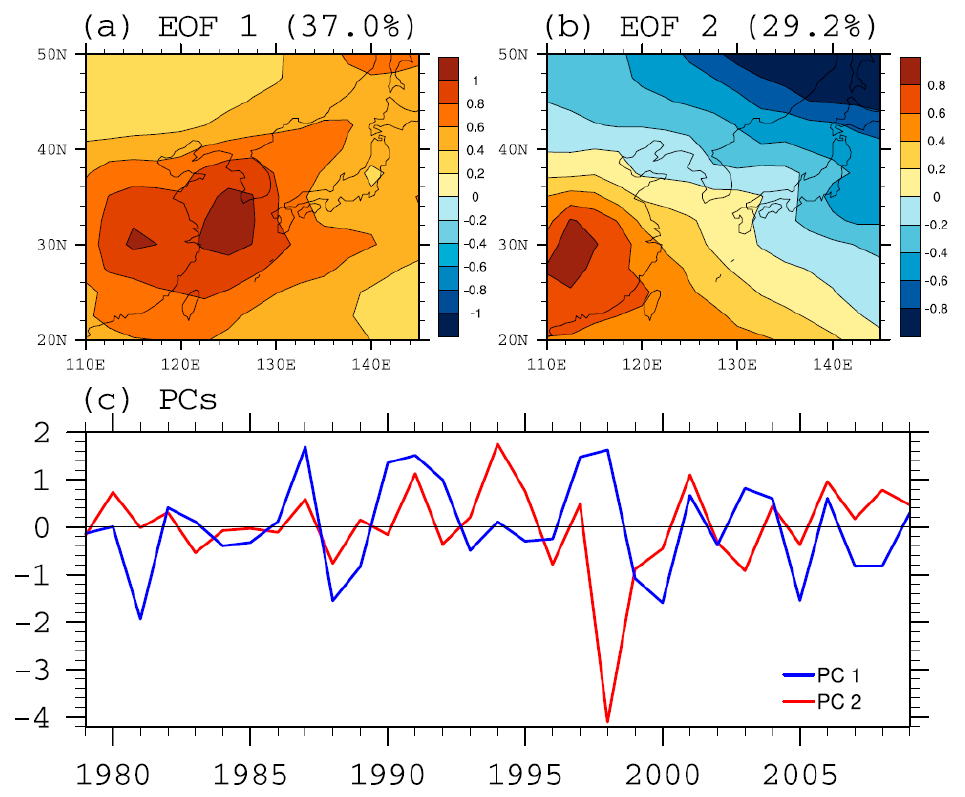
Figure 5. Same as Figure 2, except for the detrended ozone.